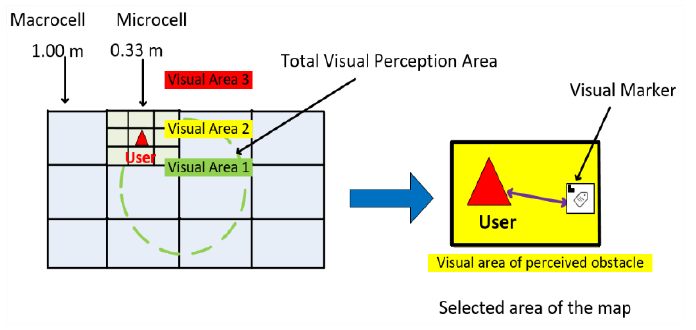
Figure 3. Target tracking scheme.